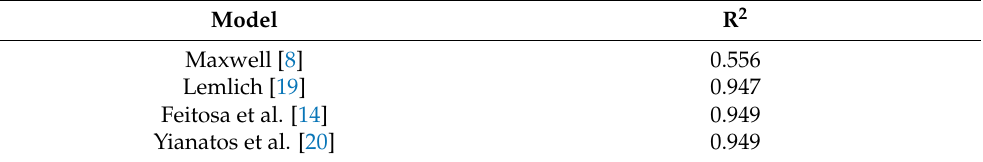
Table 4. R 2 values for data obtained in this study, and various models from the literature.